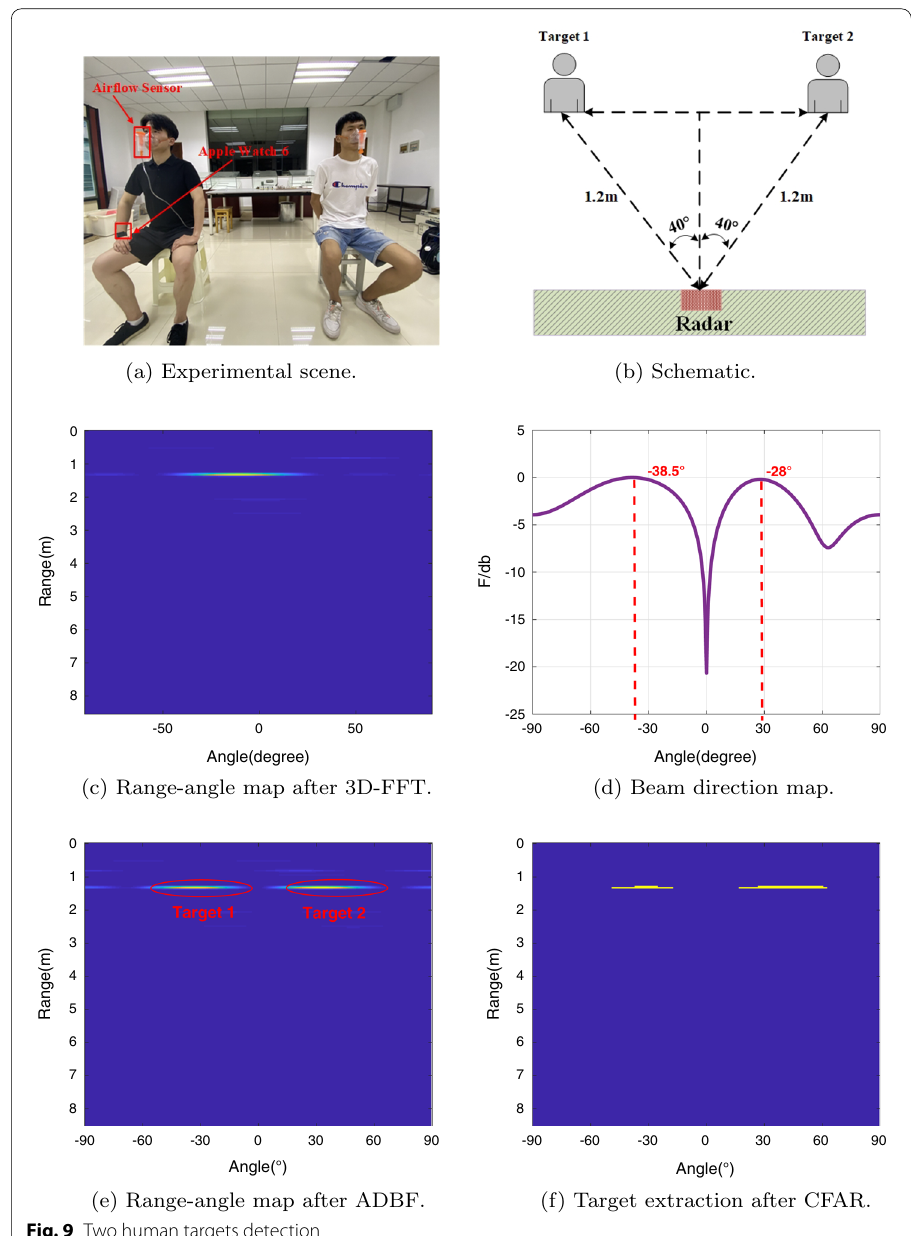
Fig. 9 Two human targets